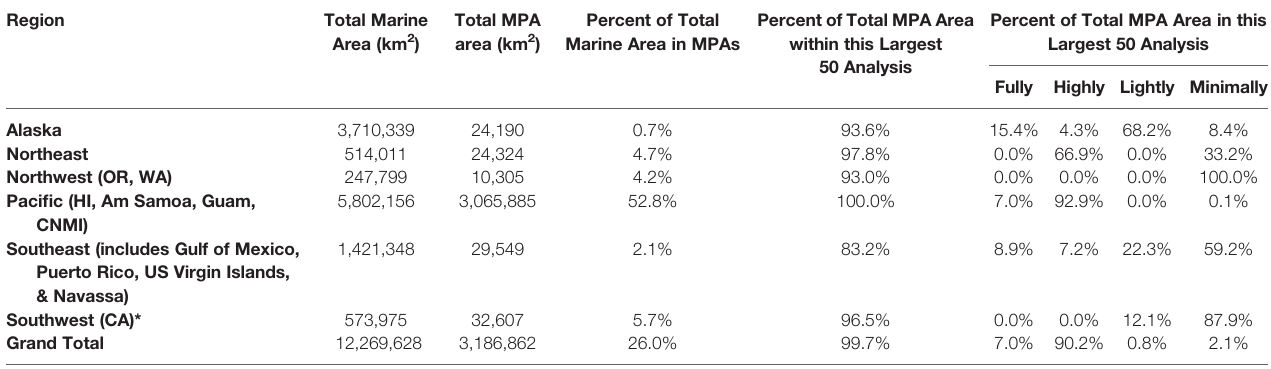
TABLE 3 | Area and percent of MPAs in each U.S. Region that fall within the largest 50 U.S. MPAs (analysis presented here, excluding area for which level of protection was unknown – 0.05% of analysis), by level of protection.